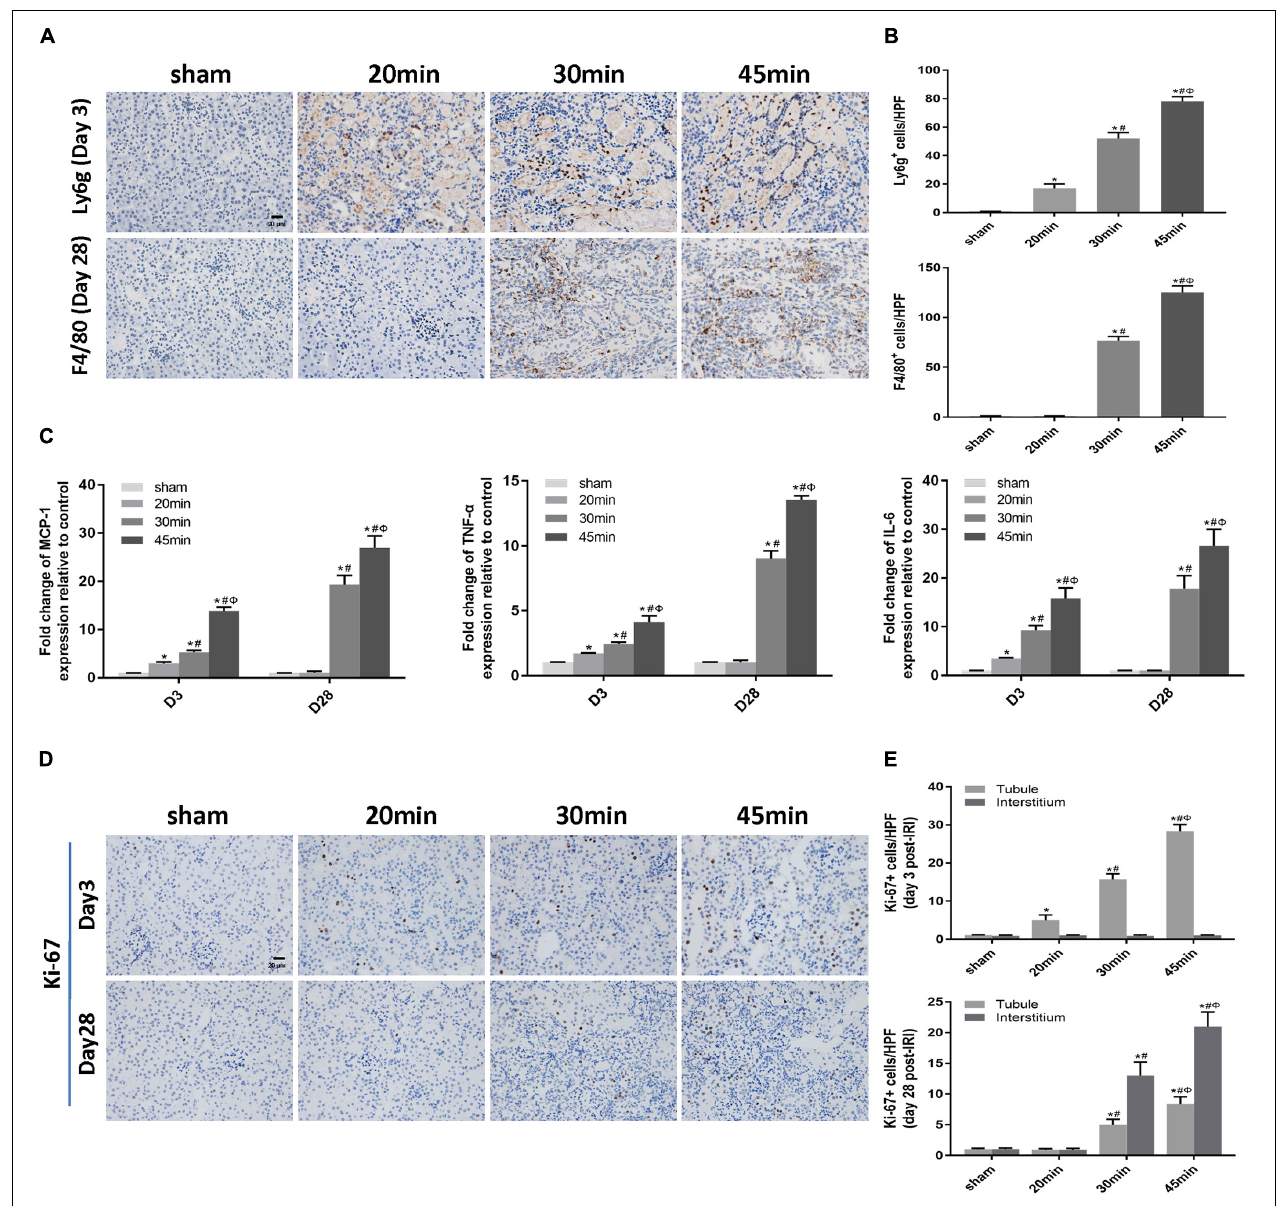
FIGURE 5 | Elevated inflammation was associated with IRI-induced AKI severity and the AKI-to-CKD transition. (A) Immunohistochemical staining of Ly6g (a neutrophil marker) at day 3 and F4/80 (a macrophage marker) at day 28 post ischemia in kidneys subjected to different durations of ischemia (original magnification × 400; Scale bar, 20 µ m). (B) Semiquantitative data of Ly6g and F4/80 staining in different groups of mice. (C) Expression of inflammatory mediators (MCP1, TNF- α , and IL-6) was measured by real-time PCR. (D) Immunohistochemical staining of Ki-67 (a marker of proliferation) at day 3 and day 28 post ischemia in kidneys subjected to different durations of ischemia (original magnification × 400; Scale bar, 20 µ m). (E) Semiquantitative data of Ki-67 staining in different groups of mice. T, tubule; I, interstitium. Data are presented as the means ± SEM of four experiments. n = 6; ∗ P < 0.05 vs. the control group. # P < 0.05 vs. the 20 min-ischemia group. (cid:56) P < 0.05 vs. the 30 min-ischemia